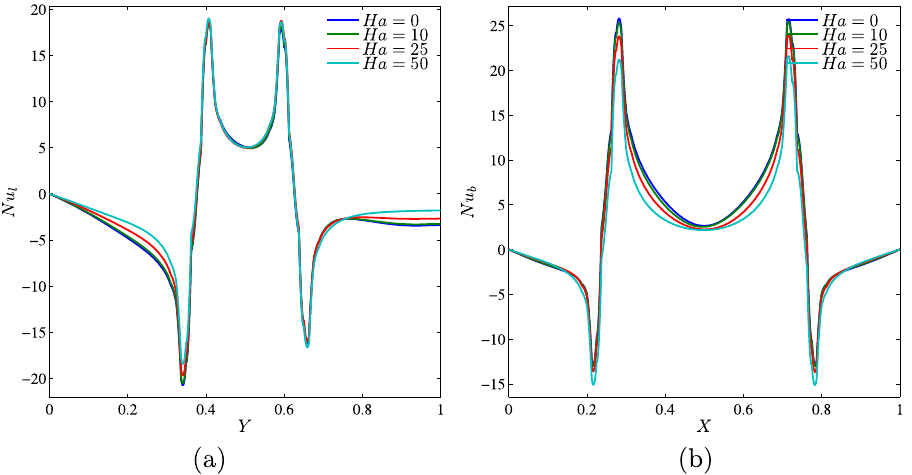
Figure 14. Variation of local Nusselt number interfaces with ( a ) Y and ( b ) X for different Ha at Ra = 10 5 , φ = 0.02, k w = 0.76 and D = 0.3.